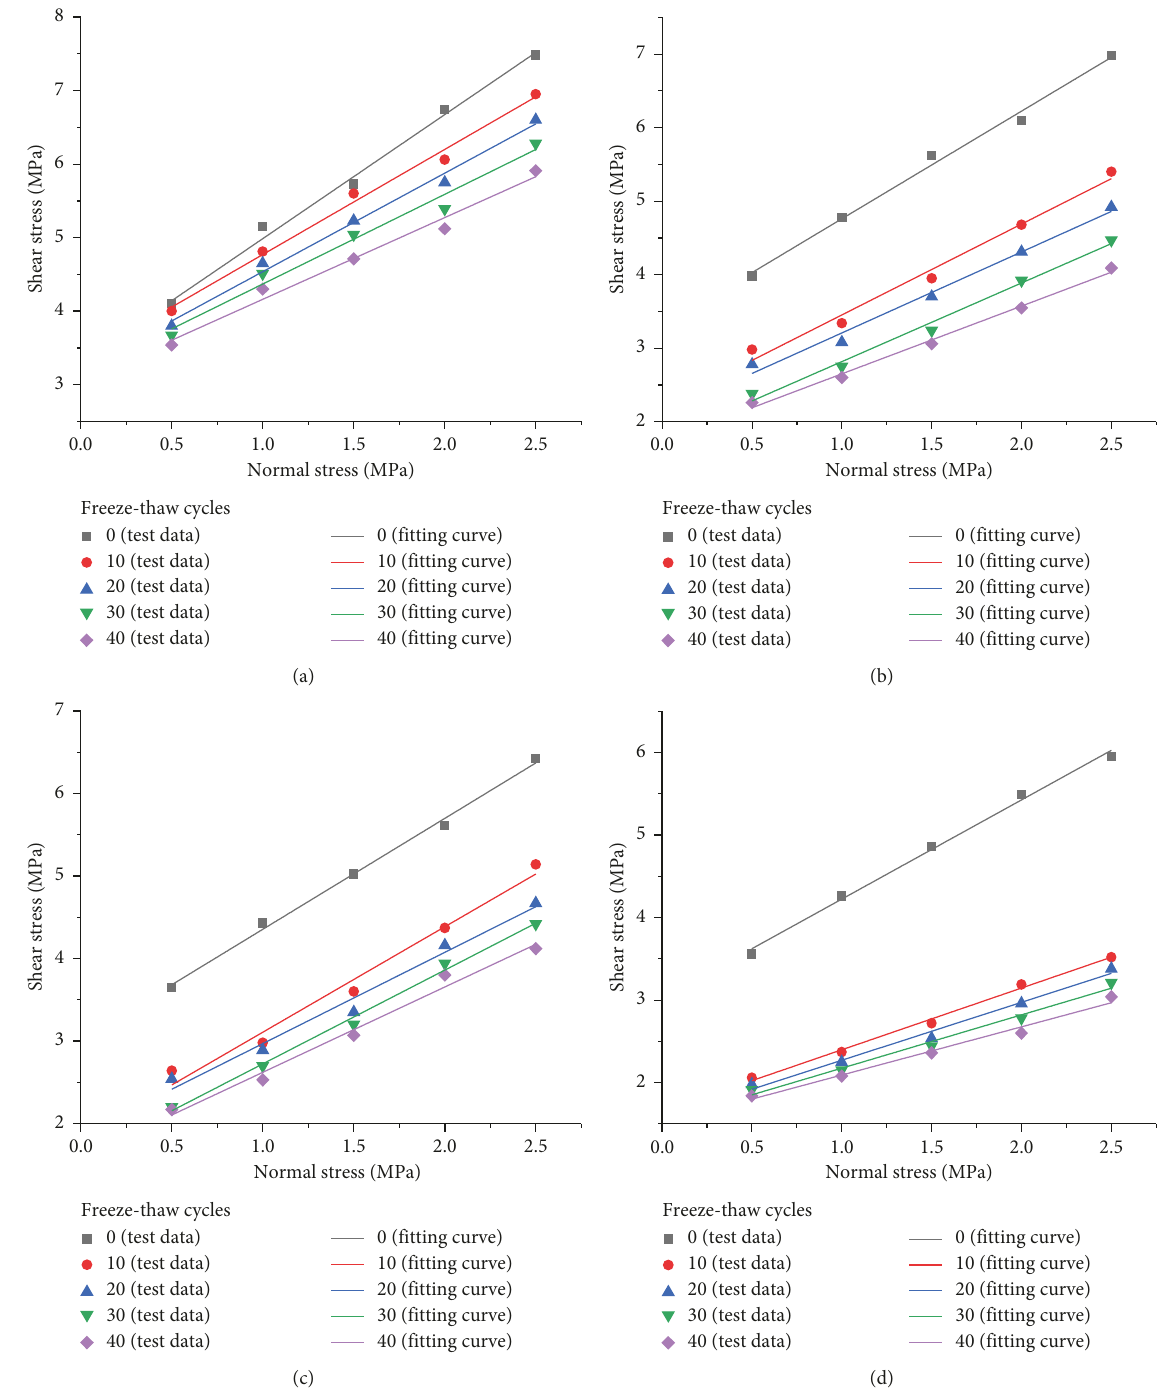
Figure 12: The relationship between peak shear stress and normal stress under different freezing-thawing cycles. (a) λ � 0% specimen, (b) λ � 20% specimen, (c) λ � 30% specimen, and (d) λ � 40%